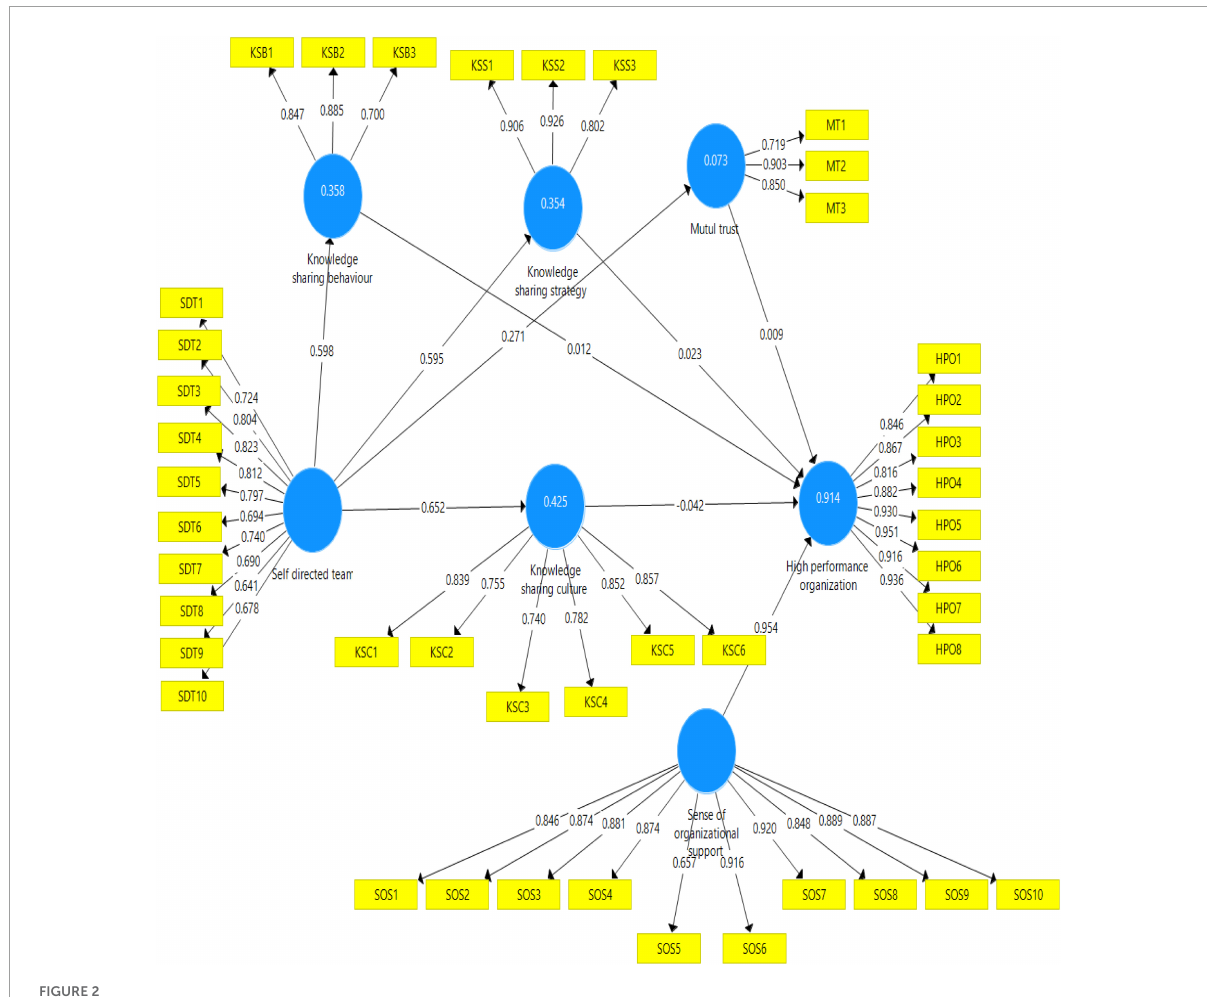
FIGURE2 Measurement